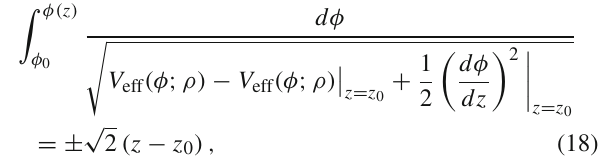
Table 2 The limitsofthe twoconstituent partsof theeffective potential Eq. (4) are summarized in this